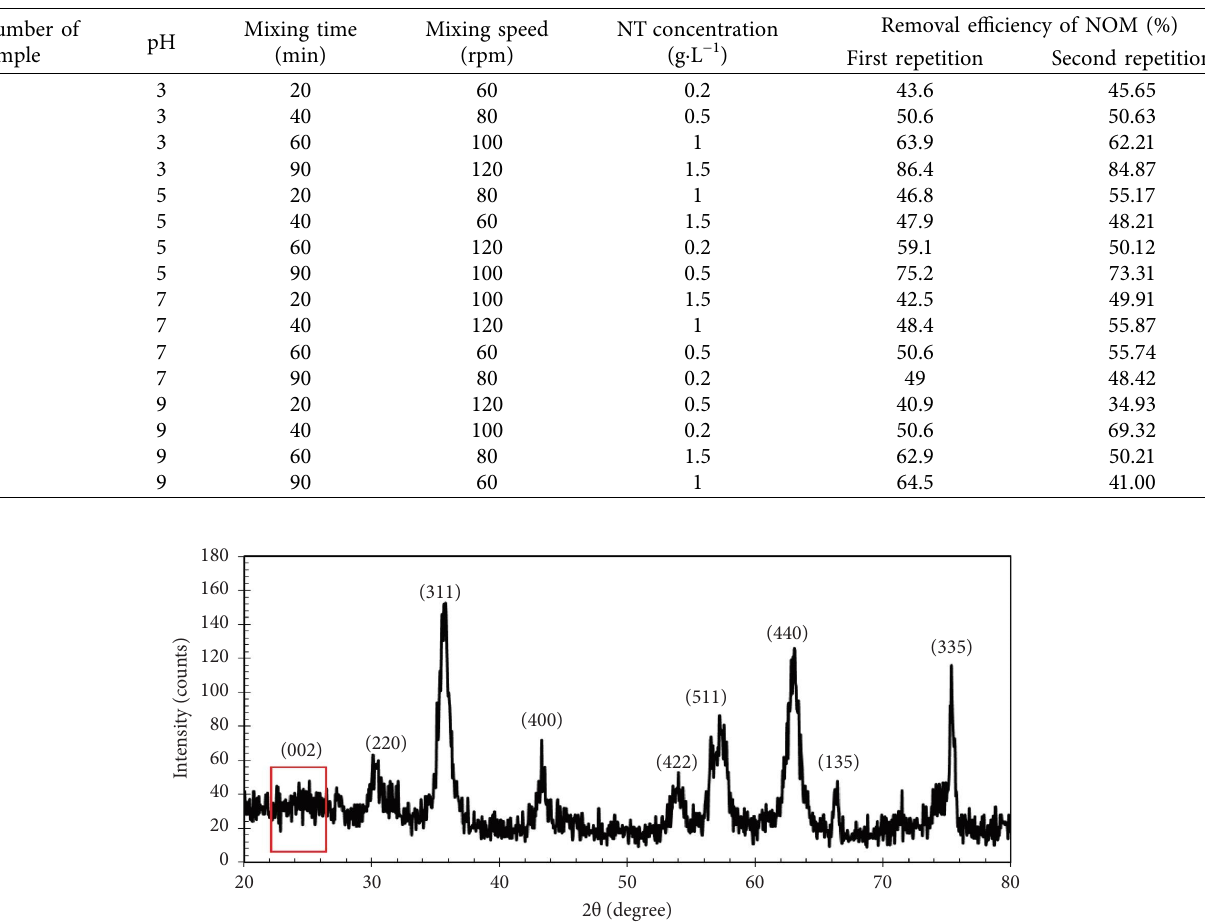
Table 5: Removal percentage of natural organic matter at a concentration of 20mg · L − 1 .